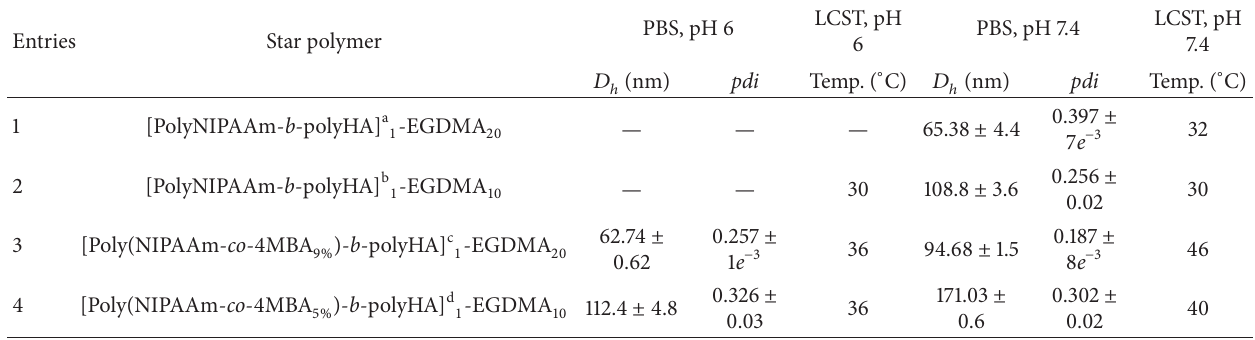
Table 4: Hydrodynamic diameters and LCST values of star polymers, in PBS at pH 6 and in PBS at pH 7.4.